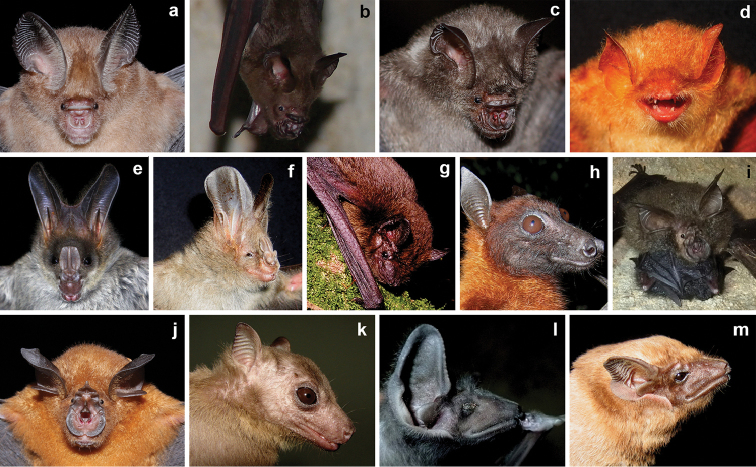
Bat species recorded in the periphery of Maduru-Oya National Park. aHipposiderosaterbHipposideroslankadivacHipposiderosspeorisdKerivoulapictaeMegadermalyrafMegadermaspasmagPipistrellustenuishPteropusgiganteusiRhinolophusbeddomeijRhinolophusrouxiikRousettusleschenaultilTaphozouslongimanusmTaphozousmelanopogon.